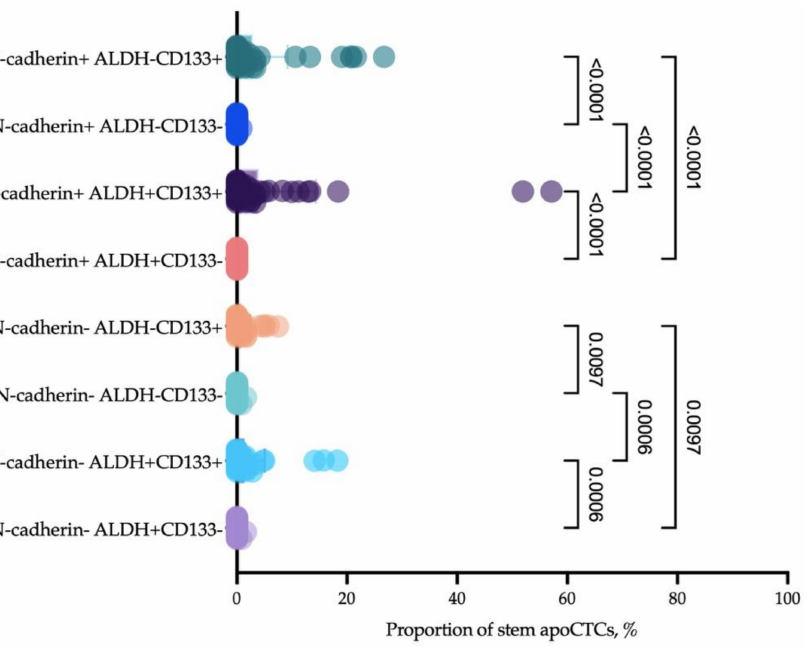
Figure 8. Proportion of CD44+CD24 − apoCTCs (considered as 100%) that expressed mesenchymal features (N-cadherin) and additional features of stemness (CD133 and